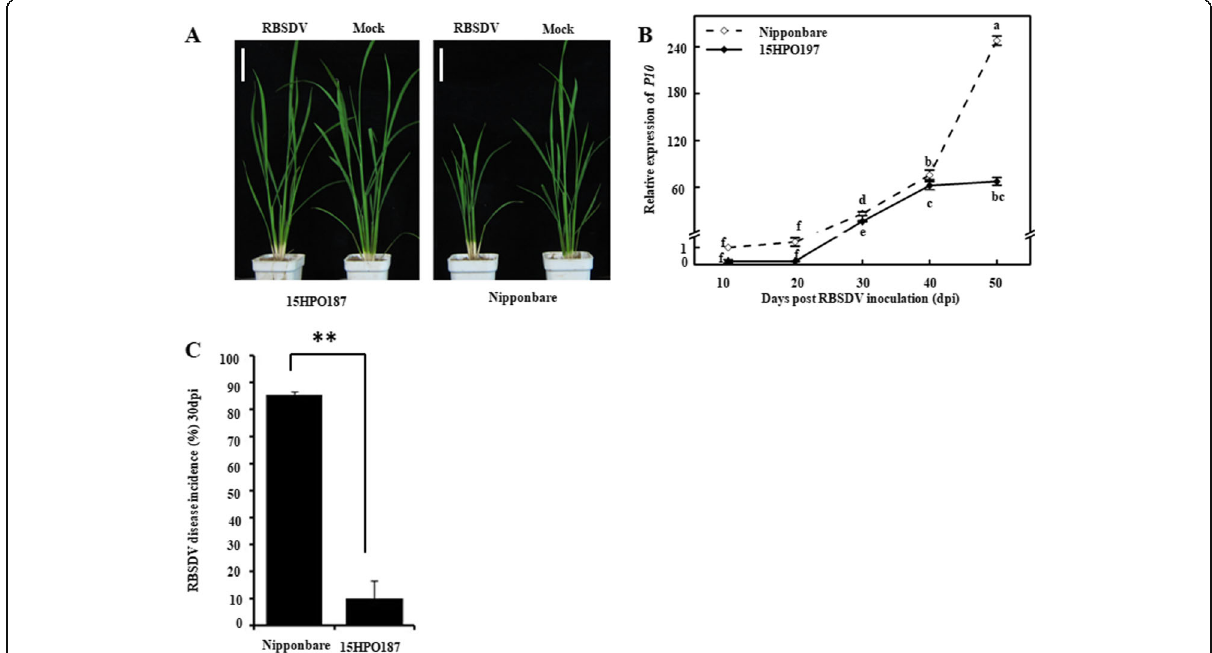
Fig. 1 The plant growth of Nipponbare and 15HPO187 challenged with RBSDV infection. a A mock- or RBSDV-inoculated Nipponbare (left) or 15HPO187 (right) plants photographed at 30 dpi. b Time-course analysis of RBSDV P10 gene in the RBSDV-inoculated Nipponbare or 15HPO187 plants at various dpi. Five plants were pooled together as one biological experiment for each time point for analysis. The data represented the means ± SD of three biological replicates. Entire experiment repeated 3 times with similar results. c RBSDV disease incidence of the Nipponbare and 15HPO187 rice was determined at 30 dpi. 30 two-leaf stage rice seedlings of each cultivar were tests for disease incidence experiment. Scale bars = 5 cm. Images are representative of three independent biological experiments. The data represented the means ± SD of the three replicates. Different low case letters above the bars indicate the statistical differences between the treatments using the Duncan ’ s multiple test, **, p < 0.01. Mock, plants were inoculated with non-viruliferous SBPHs; RBSDV, plants were inoculated with RBSDV viruliferous